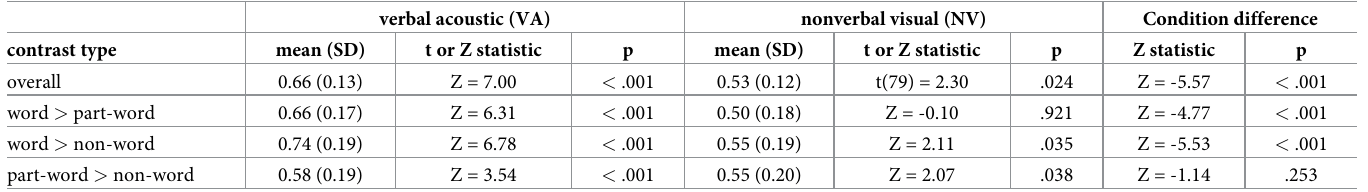
Table 2. Descriptive statistics of 2AFC measures, their differences from the chance level of 0.5 and their condition effects. verbal acoustic (VA) nonverbal visual (NV) Condition